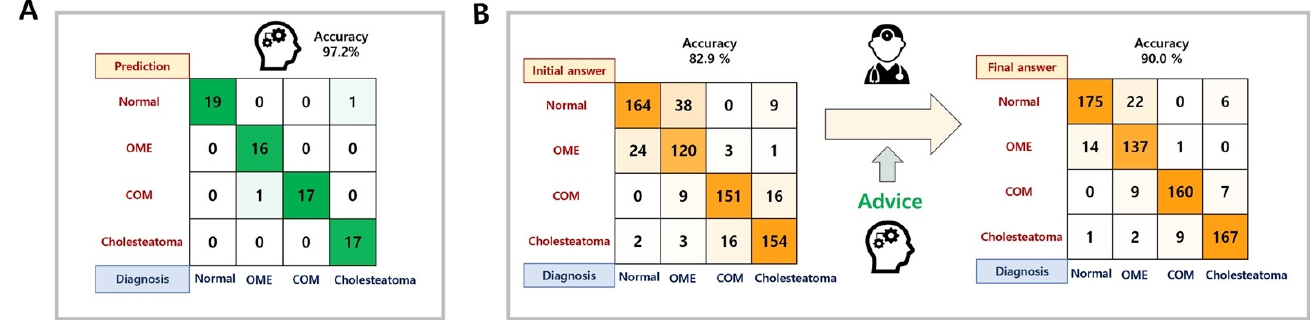
Figure 5. The confusion matrix for the diagnostic results for the machine learning network and resident physicians. ( A ) Prediction accuracy of the machine learning network in the representative cases, ( B ) The diagnostic performance change of ten resident physicians with the assistance of the machine learning network.